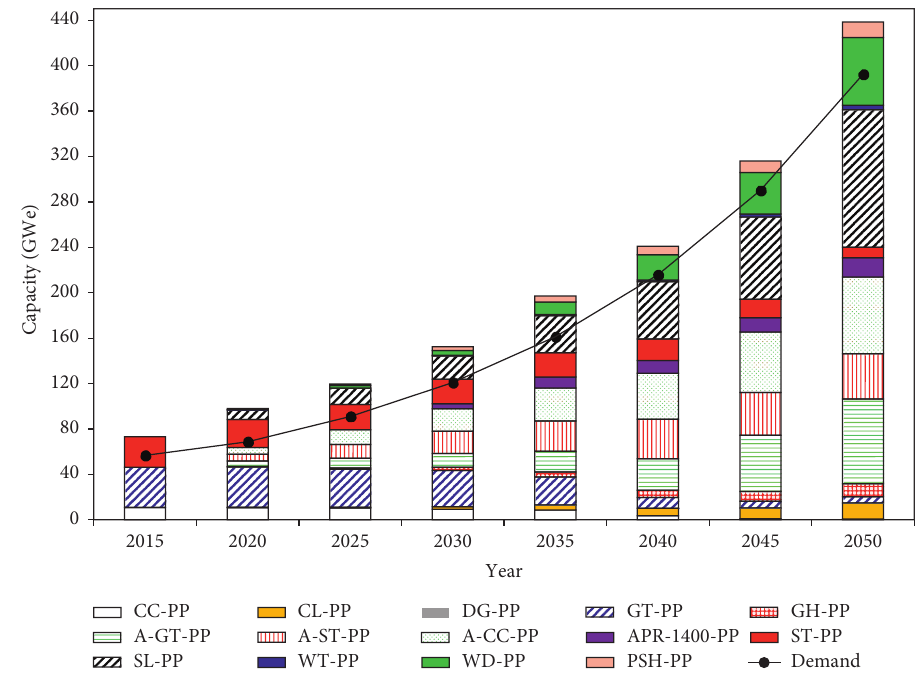
Figure 7: Simulation results from MESSAGE tool for Subscenario